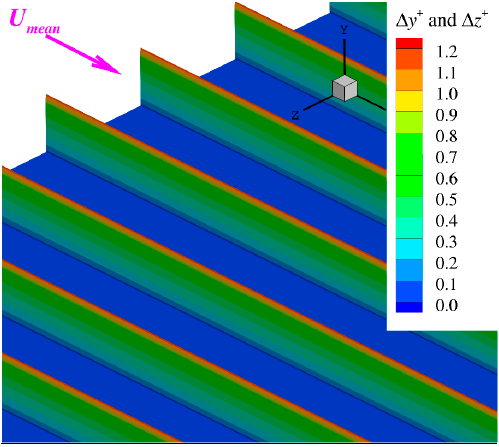
Figure 2. Wall-normal Δ y + and spanwise Δ z + on the riblet side.